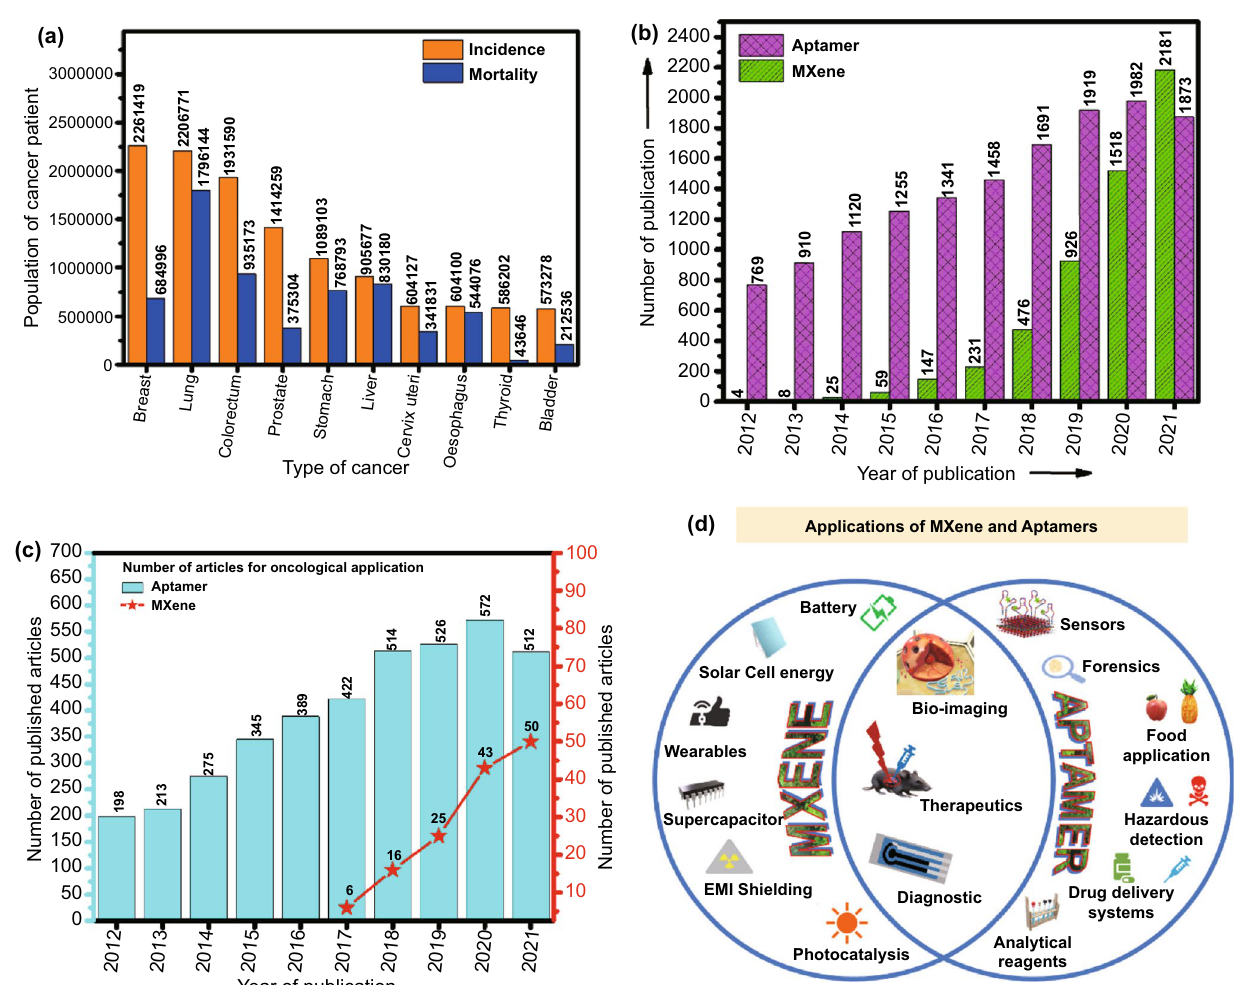
Fig. 1 Graphical representation of a estimated number of incident cases and mortality worldwide, both sexes and all ages (last access date: 10.12.2021); b the literature published on aptamer and MXene in last decade; c number of literature published for oncological application of aptamer and MXene in last decade (last access date: 16.12.2021). d Applications of MXene and